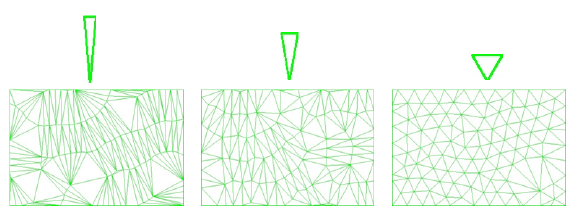
Figure 3. Shape prior. Three triangulations are simulated using different triangle shapes from low (left) to high (right)